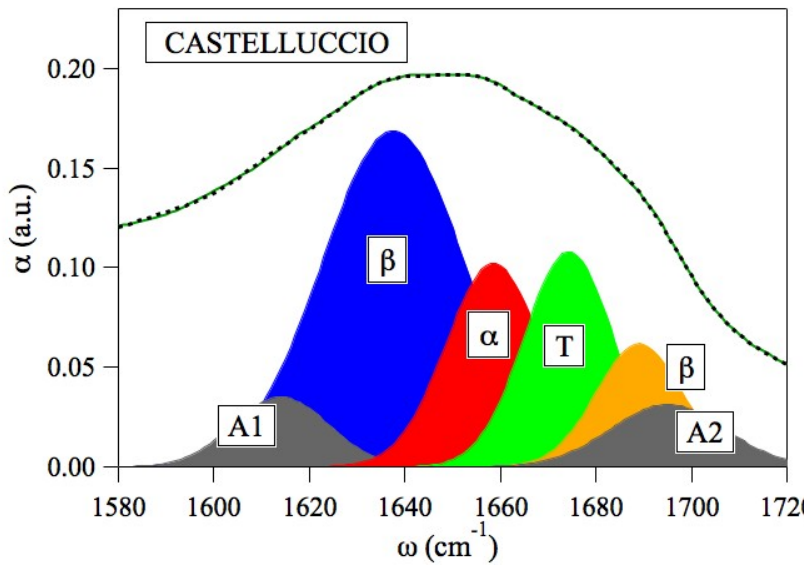
Figure 1. Analysis of proteins of Castelluccio lentil PGI (protected geographical indication) by FTIR. The amide I band was deconvolved by gaussian contributes. A1: intermolecular aggregates; β: β-sheet; α: α-helix; T: turns, A2: β-aggregates. (Carbonaro and Nucara, personal communication). Legume proteins presented quite a lower α-helix to β-sheet ratio than cereal proteins (0.47 and 1.1, respectively) [46]. A different α-helix to β-sheet ratio was found in a recent